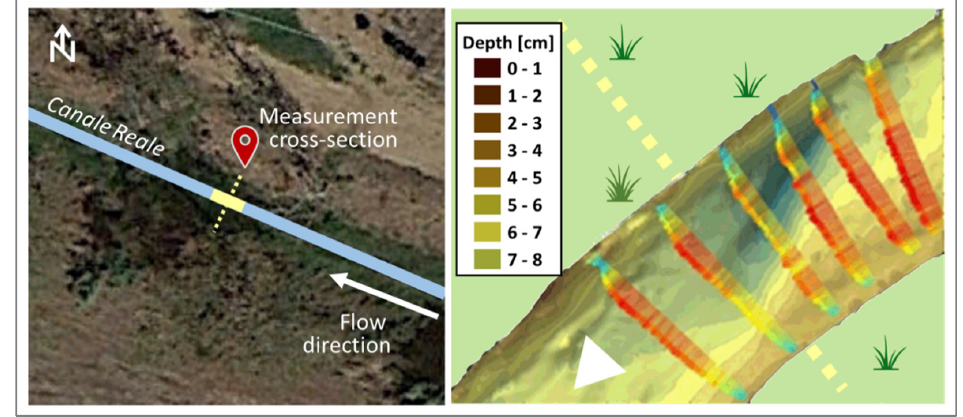
Figure 12. Detection of different layers and waves of the channel vs. depth for cross-section B1.